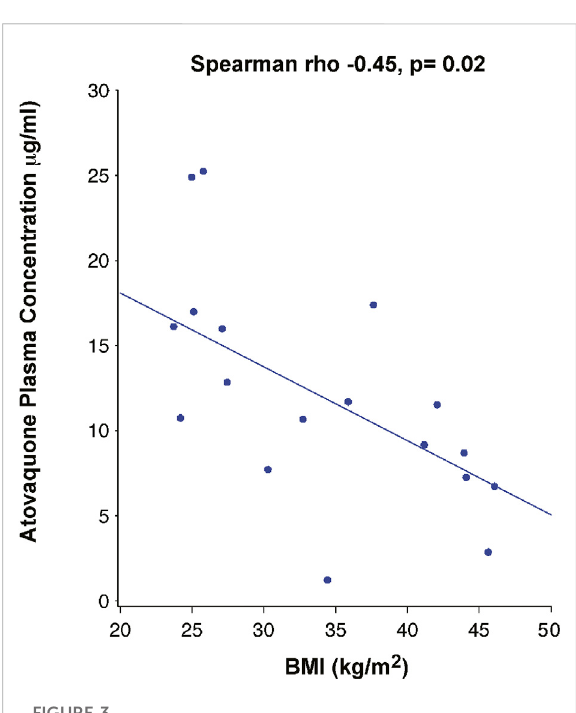
FIGURE 3 Correlation Between Atovaquone Plasma Concentration and BMI. Pharmacokinetic studies showed a negative correlation between atovaquone and BMI 5 days following initiation of atovaquone (rho − 0.45,